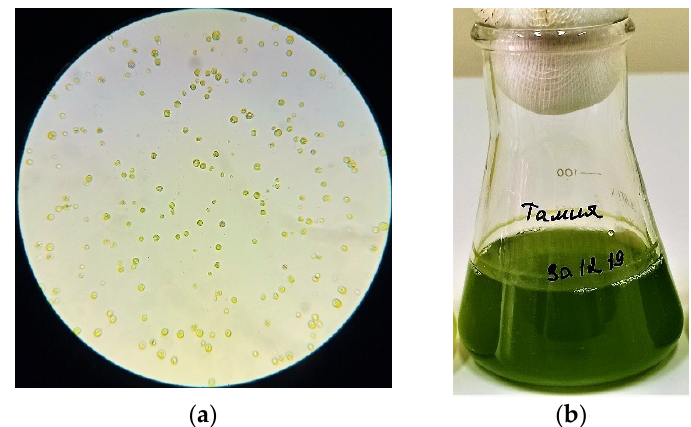
Figure 1. The results of studying the morphological features of the microalgae Chlorella vulgaris and their suspensions: ( a ) Cells under a microscope; ( b ) The suspension’s appearance.